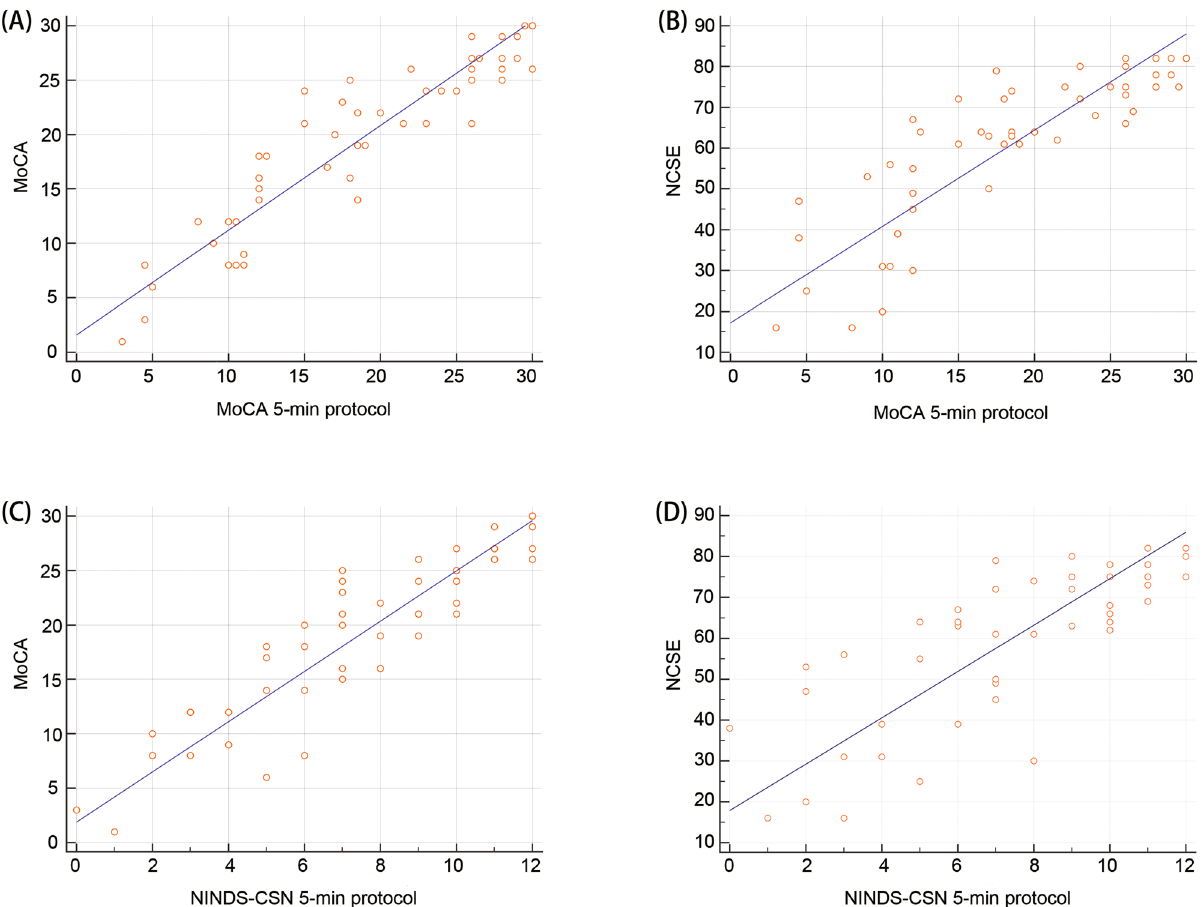
Figure 1. ( A ) Scatter plot of the relationship between total scores of the MoCA 5-min protocol vs the full MoCA; ( B ) Scatter plot of the relationship between total scores of the MoCA 5-min protocol and the NCSE; ( C ) Scatter plot of the relationship between total scores of the NINDS-CSN 5-min protocol and the MoCA; ( D ) Scatter plot of the relationship between total scores of the NINDS-CSN 5-min protocol and the NCSE.